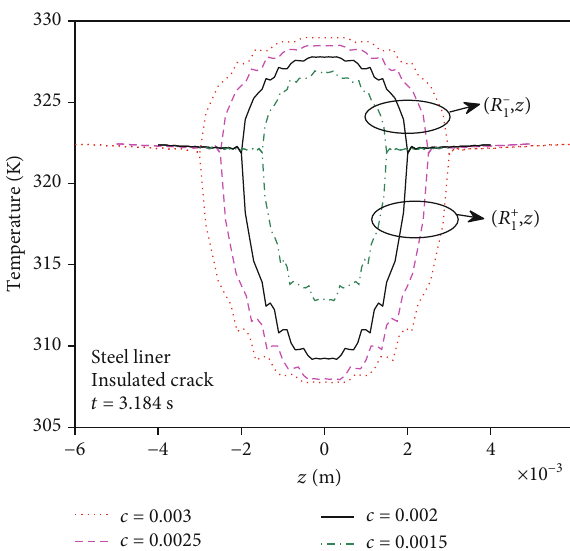
Figure 9: The e ff ect of crack length on the history of heat fl ux at